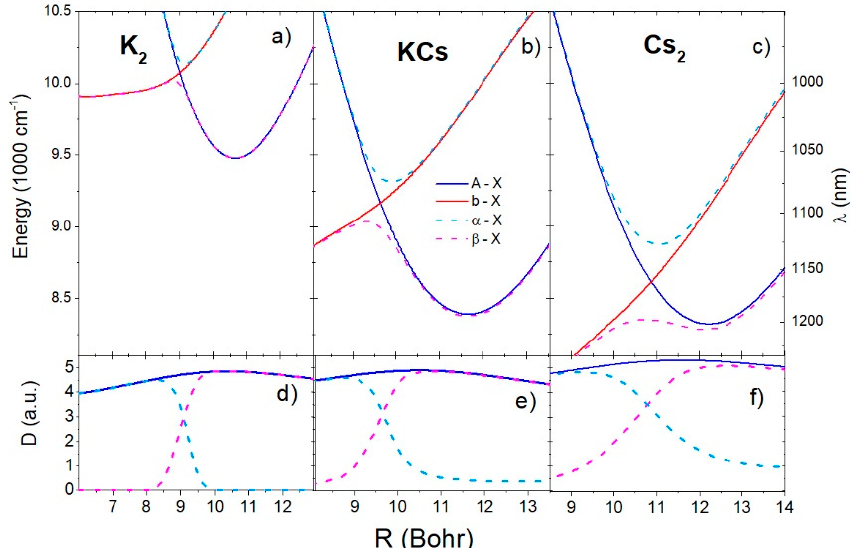
Figure 4. Difference potential curves of the A-X, b-X, α -X, and β -X transitions for K 2 , KCs, and Cs 2 molecules are shown in ( a – c ), respectively. The corresponding transition dipole moments are shown in ( d – f ). The labels on the left side of the upper panel denote energy, and the right-side denotes the wavelength of the transition.